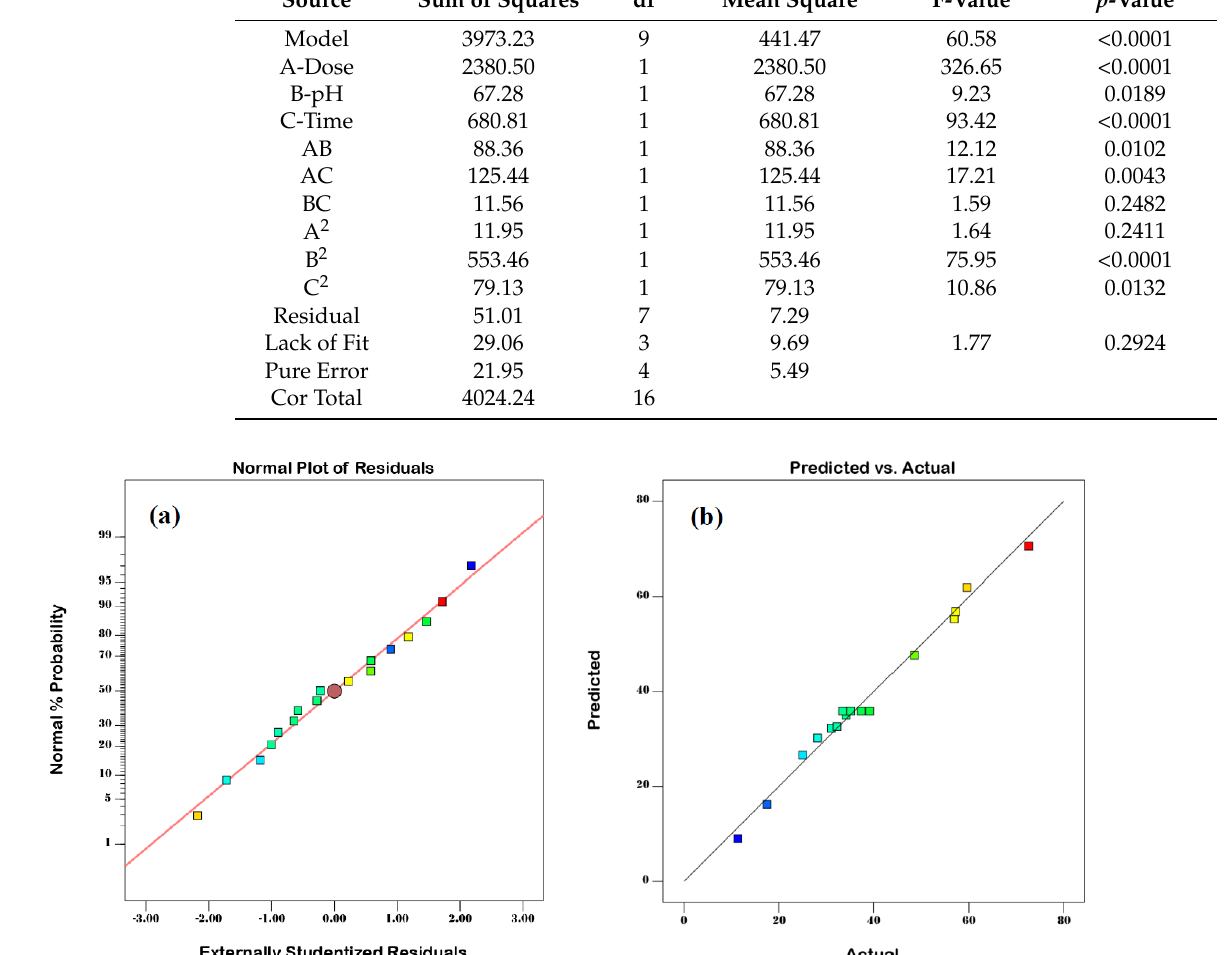
Figure 4. ( a ) Normal probability plot of residuals for MV 2B removal and ( b ) the plot of the relation- ship between the predicted and actual values of MV 2B removal.